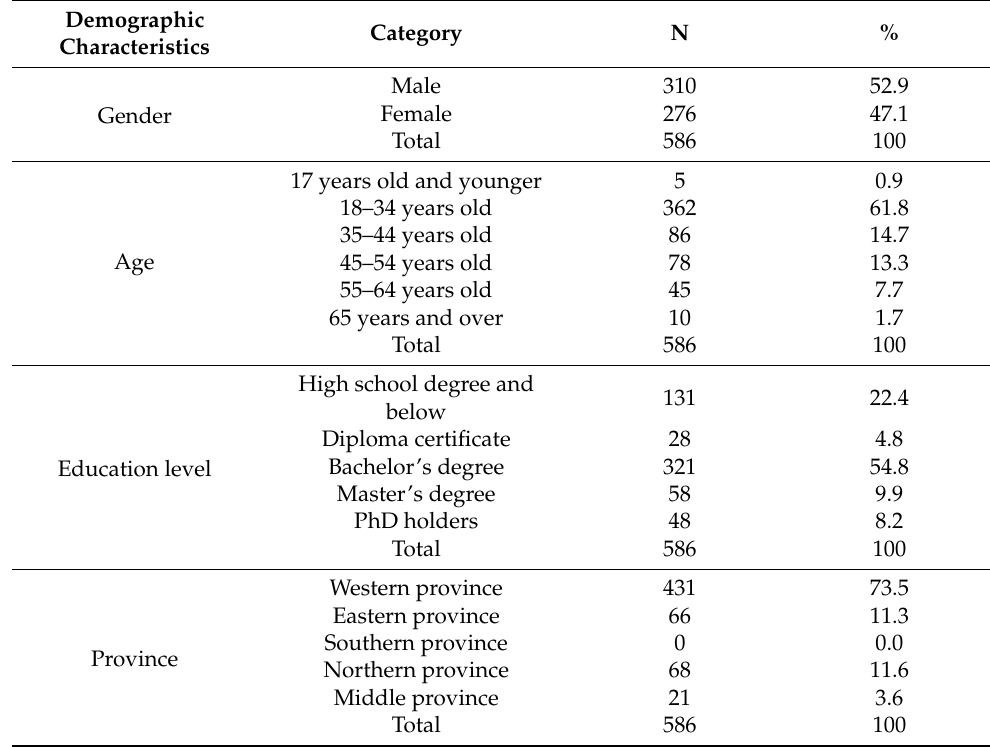
Table 1. Demographic characteristics of the